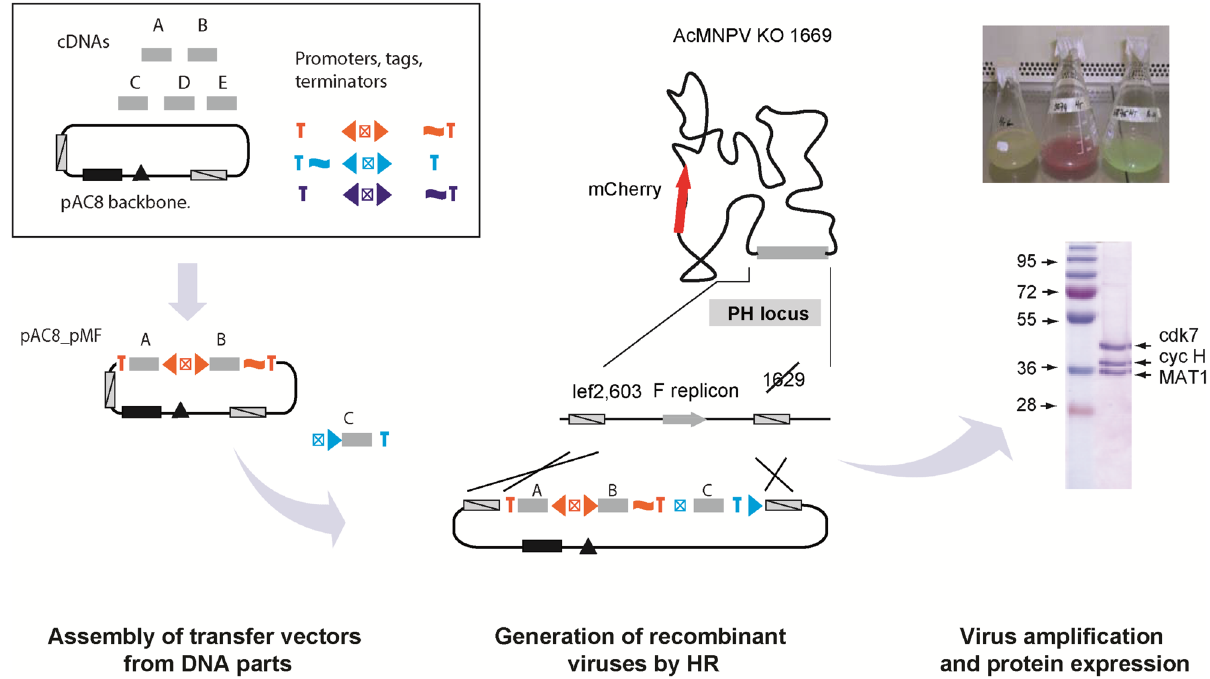
Figure 5. The HR-bac toolbox. To assemble dual expression cassettes into transfer vectors, DNA elements comprising the plasmid backbone, cDNAs encoding the target genes and promoter modules (typically comprising the PH and p10 promoters) are combined in a single-step four-fragment homology-based assembly reaction. Expression cassettes can be excised by digestion with a pair of restriction endonucleases or amplified by PCR and inserted via compatible restriction sites or homology-based cloning into the multiplication module of a progenitor plasmid. An example in which an expression cassette containing genes C is cloned into a plasmid containing genes A and B is shown. Viruses are generated by co-transfection of insect cells with a transfer plasmid enclosing the expression cassette and a bacmid containing a defective version of the viral genome. As the bacmid is unable to initiate virus replication unless rescued by the transfer vector, the need for post- production screening is eliminated and recombinant viruses can be directly amplified, allowing to generate viruses from transfer vectors and express proteins in 2 weeks. Expression of a fluorescent marker proteins allows to monitor virus propagation. The full-length gel of the purified complex is shown in Suppl. Fig.